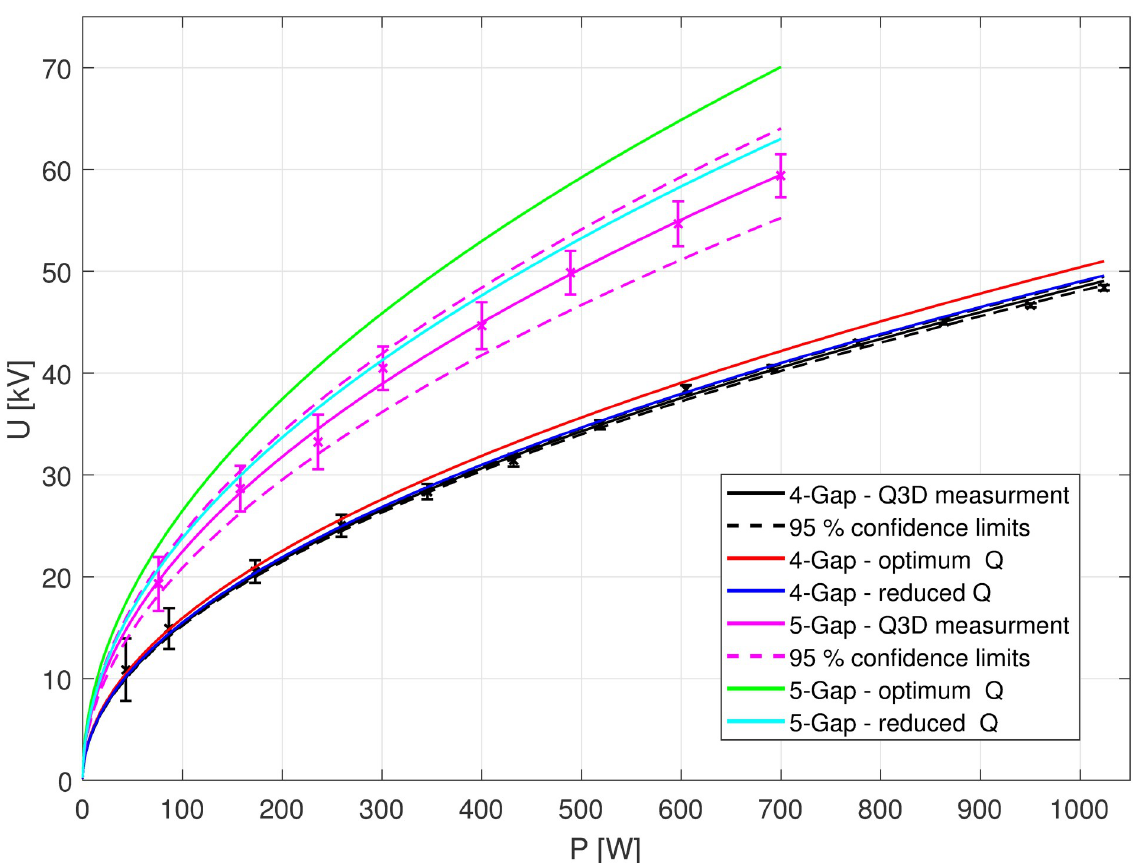
Fig 13. Performance of the two buncher concepts. Black and pink: Measurement series of the accelerator voltage U b as a function of the input power P , performed on the Q3D. Green and Red: “Best Case” scenario simulations. Light blue and dark blue: reduced measured quality in Q 0